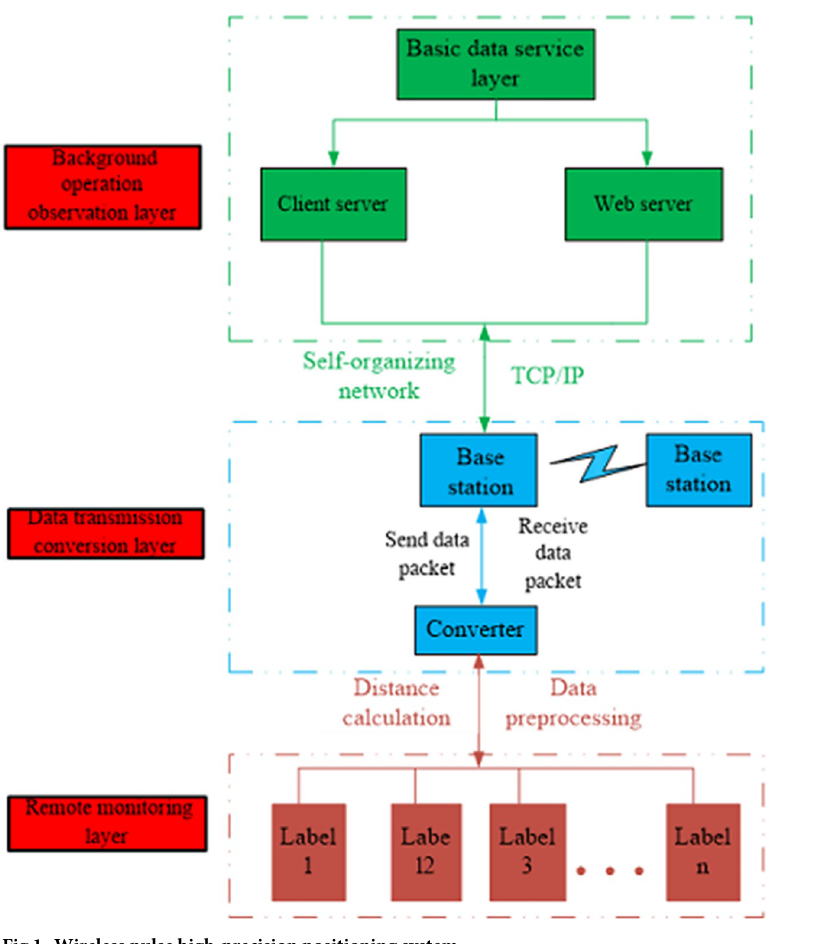
Fig 1. Wireless pulse high-precision positioning system.